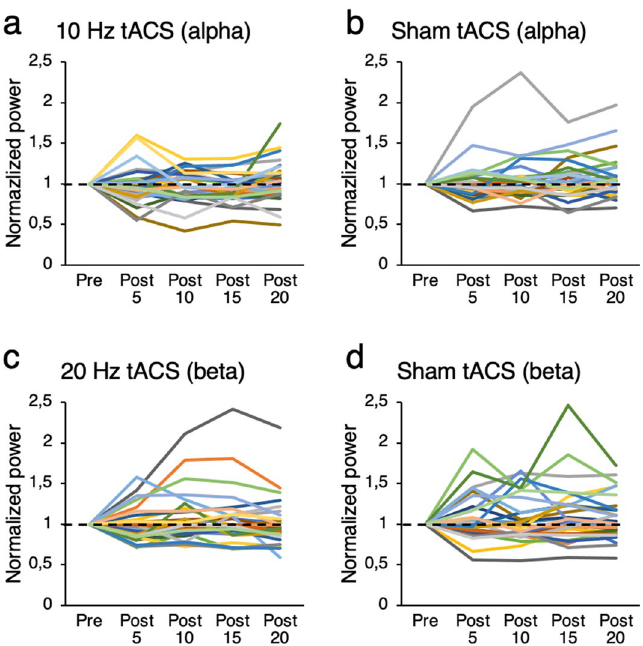
Figure 2. Individual response to tACS normalized to baseline values. Individual alpha and beta log- transformed power following 10 Hz, 20 Hz, or sham stimulation at electrode C3. Note that one participant with high power values is not presented in the figure for clarity but was included in the statistical